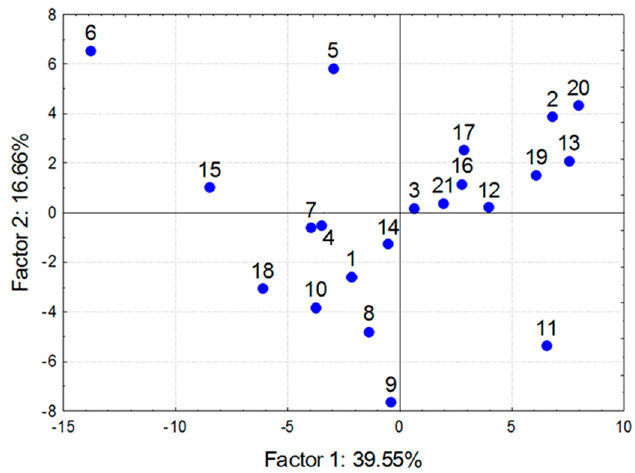
Figure 3. Principal component analysis (PCA) scattering of all 21 GC materials based on responses to triplicates of 6 odorant samples (21 sensors × 18 samples).